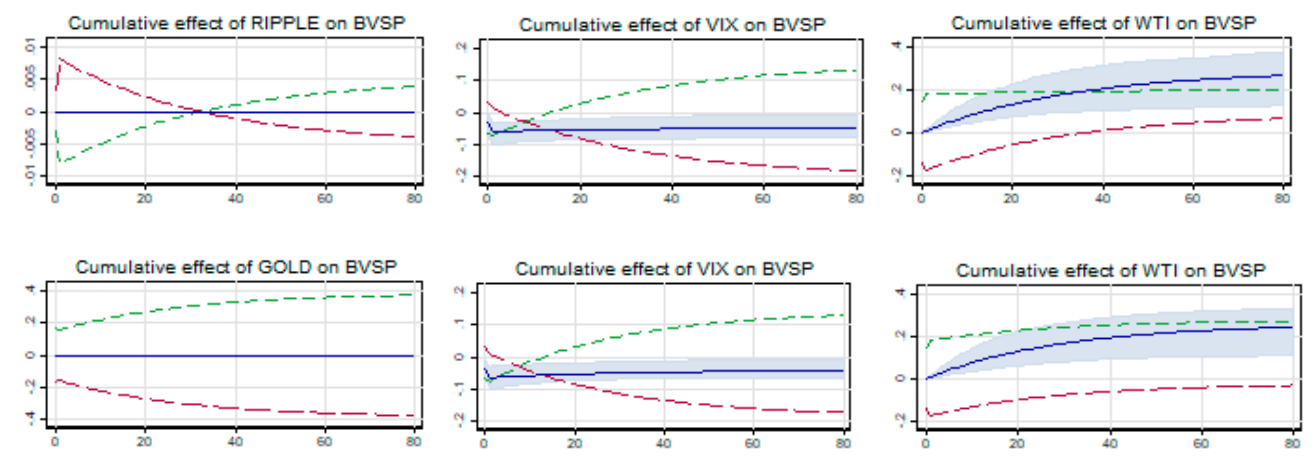
Figure 2. Cumulative effects of cryptos and gold on BVSP.